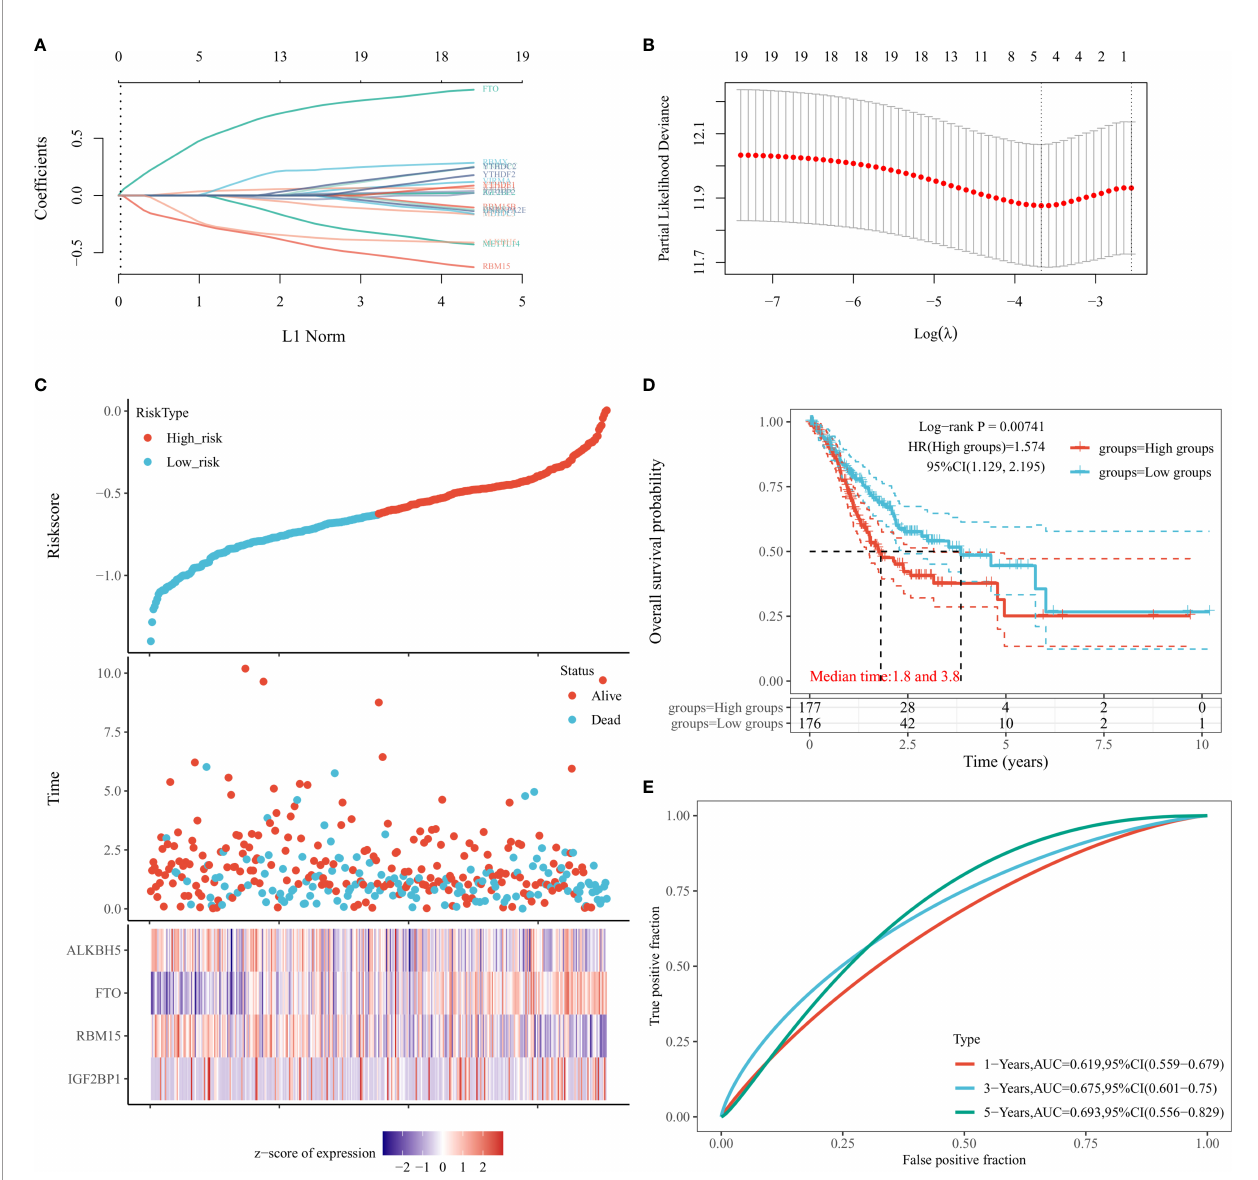
FIGURE 4 | Relationship between m6A RNA methylation regulators and prognosis of STAD patients by constructing LASSO models in TCGA database. (A, B) Relationship between the solution path of LASSO model and cross-validation mean square error (CV MSE) and model size. (C) Risk assessment subgroups of STAD patients and the expression levels of IGF2BP1, RBM15, FTO, and ALKBH5 within the subgroups. (D) Kaplan-Meier curves of STAD patients in the high-risk and low- risk groups according to risk scores. (E) ROC curves to validate the LASSO model for 1-, 3-, and 5-year prediction ef fi